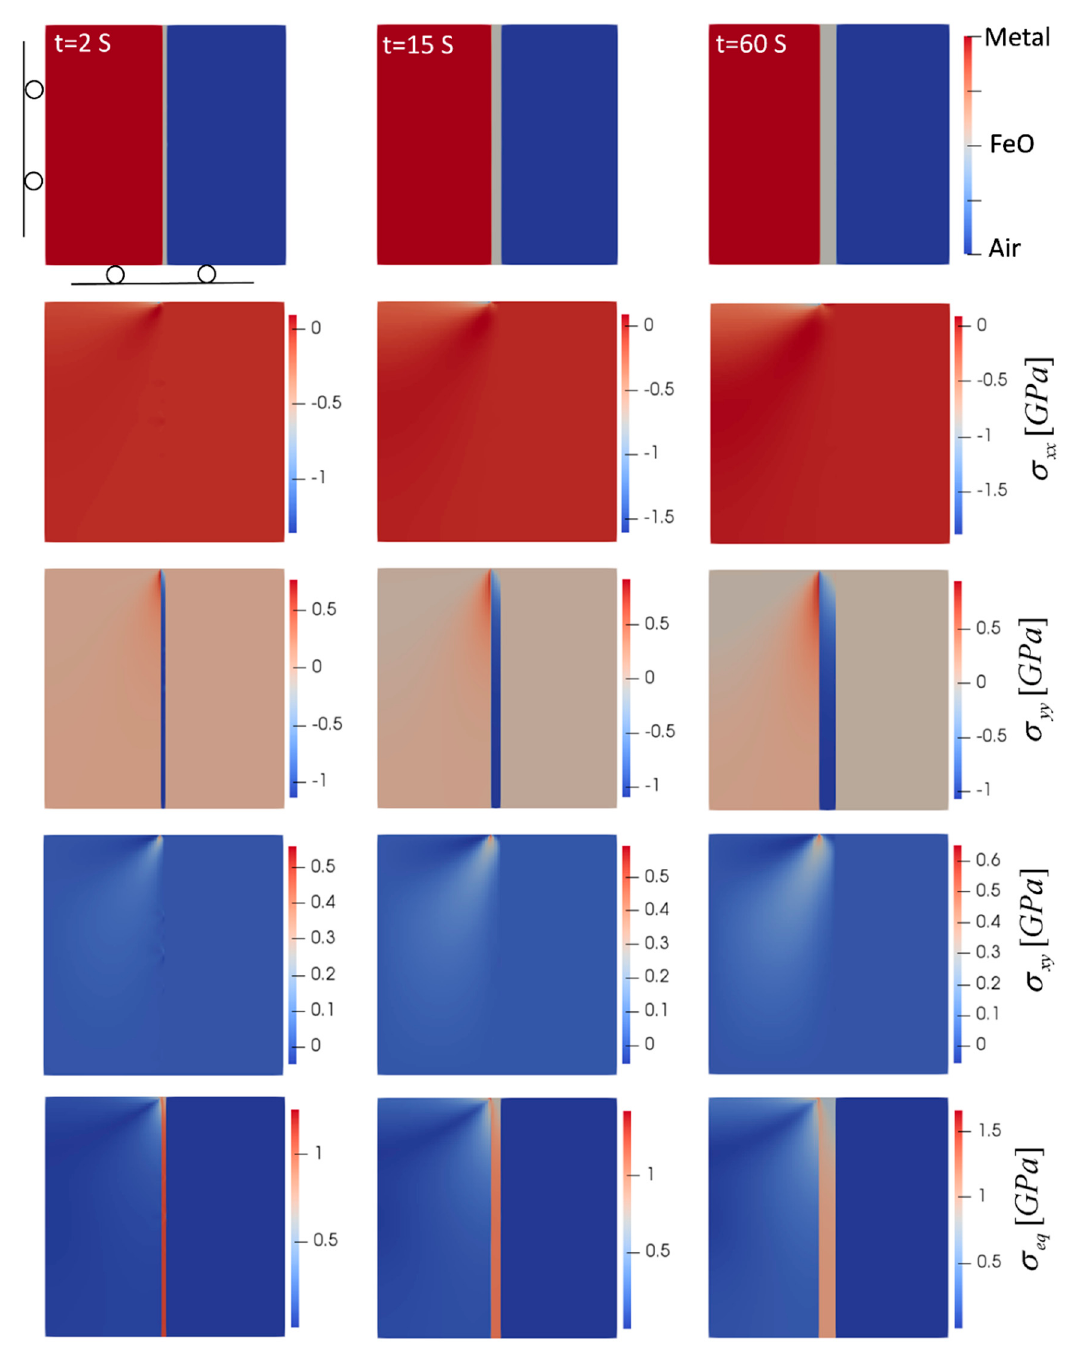
Figure 3. Oxide layer growth and evolution of induced stresses in planar oxidation (T = 850 °C). Domain size is 0.5 mm × 0.5 mm. Top left snapshot also shows the mechanical boundary conditions.